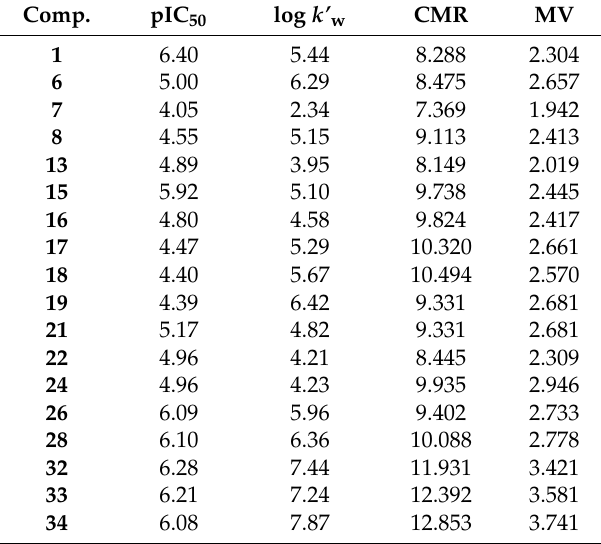
Table 6. A β antiaggregating potencies and physicochemical descriptors of isatin hydrazones. Comp.